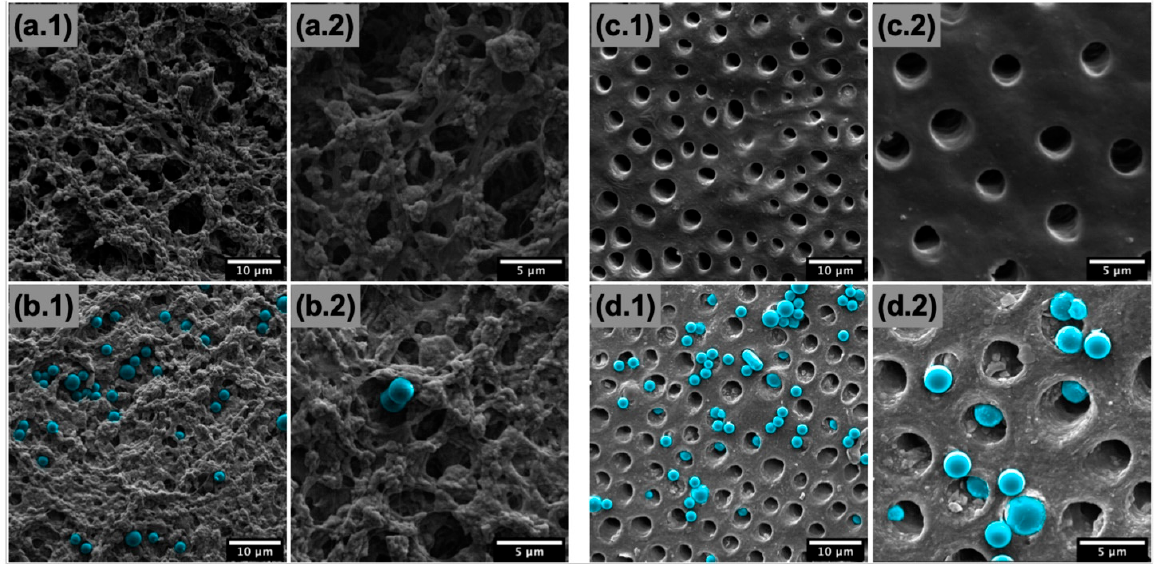
Figure 5. SEM images of ( a.1 , a.2 , b.1 , b.2 ) scaffold and ( c.1 , c.2 , d.1 , d.2 ) native dentin surfaces before ( a.1 , a.2 , c.1 , c.2 ) and after ( b.1 , b.2 , d.1 , d.2 ) addition of polystyrene microspheres (blue false colourized) mimicking occlusive particles.